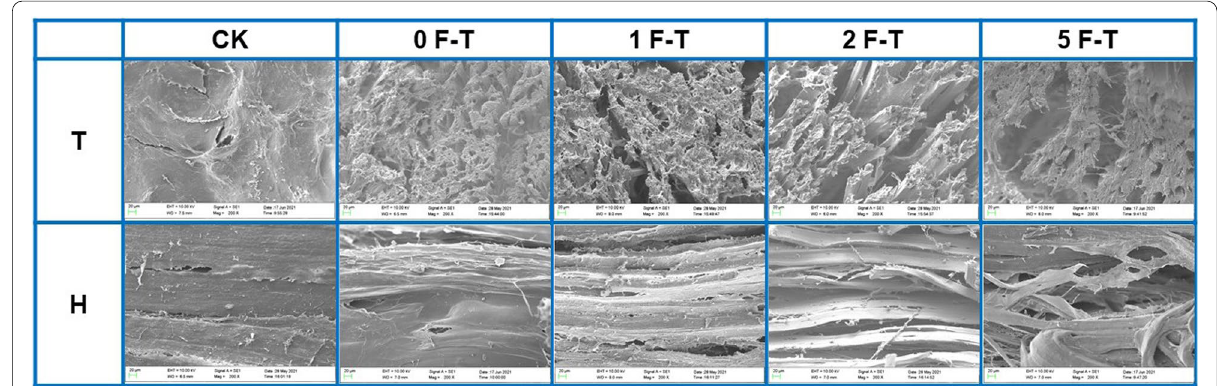
Fig. 4 Effect of repeated freeze-thaw cycles on the microstructure of cooked crayfish (T: transverse direction; L: longitudinal direction) (CK: fresh crayfish; 0 F-T: cooked crayfish with 0 freeze-thaw cycle; 1 F-T: cooked crayfish with 1 freeze-thaw cycle, 2 F-T: cooked crayfish with 2 freeze-thaw cycles, 5 F-T: cooked crayfish with 5 freeze-thaw cycles)